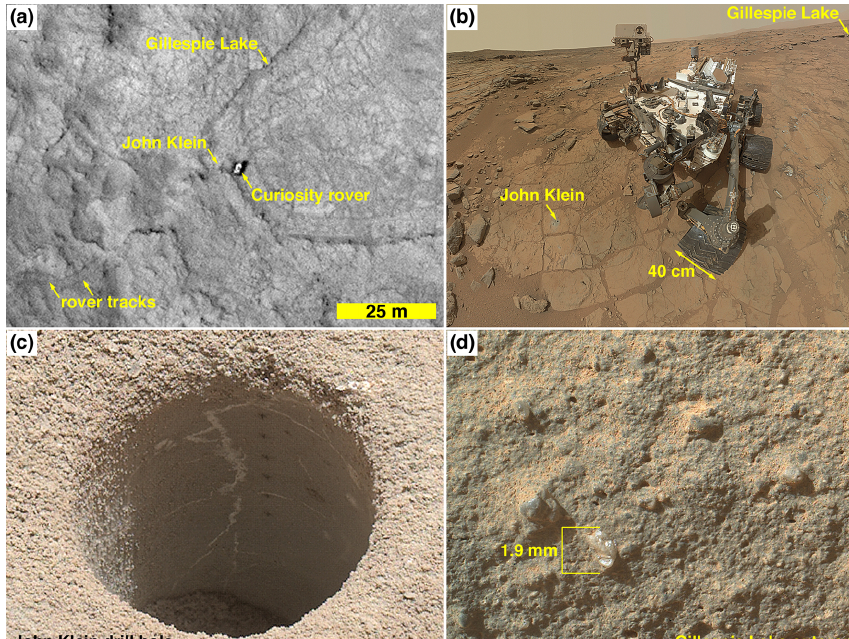
Figure 2. MAHLI is designed to be able to provide a combination of a relatively large field of view (ideal for mosaics, landscape views, and hardware inspection) and high spatial resolution (for geologic investigation), allowing the camera to be used to acquire images that connect grain-scale views to landscape- and regional-scale views. (a) Mars Reconnaissance Orbiter (MRO) High Resolution Imaging Experiment (HiRISE) orbiter camera view of Curiosity’s Yellowknife Bay field site, with the Gillespie Lake outcrop and John Klein sample extraction (drill hole) sites indicated. Illuminated by sunlight from the lower left, this is a portion of HiRISE image ESP_030313_1755; it shows the rover position on sol 156 (13 January 2013). (b) Mosaic of MAHLI images acquired on sols 177 (3 February 2013) and 270 (10 May 2013) showing locations of the Gillespie Lake outcrop and John Klein drill hole with the Curiosity rover for scale; this view is illuminated by sunlight from the left. (c) Oblique close-up view of the John Klein sample extraction hole that was drilled into light gray Sheepbed mudstone on sol 182 (9 February 2013). This view shows mineralized veins (white) and a vertical row of spots created by Curiosity’s ChemCam laser. The hole diameter is 16mm and sunlight illuminated the scene from the upper right; this is a portion of a focal plane merge product created on Earth after radiometric calibration of eight consecutively acquired sol 270 (10 May 2013) MAHLI images, 0270MH0002540050102792C00 through 0270MH0002540050102799C00. (d) Close-up view of the Gillespie Lake sandstone. Illuminated by sunlight from the upper left, this is a portion of MAHLI focus merge product 0132MH0001630000101282R00 created onboard the instrument from eight images acquired on sol 132 (19 December